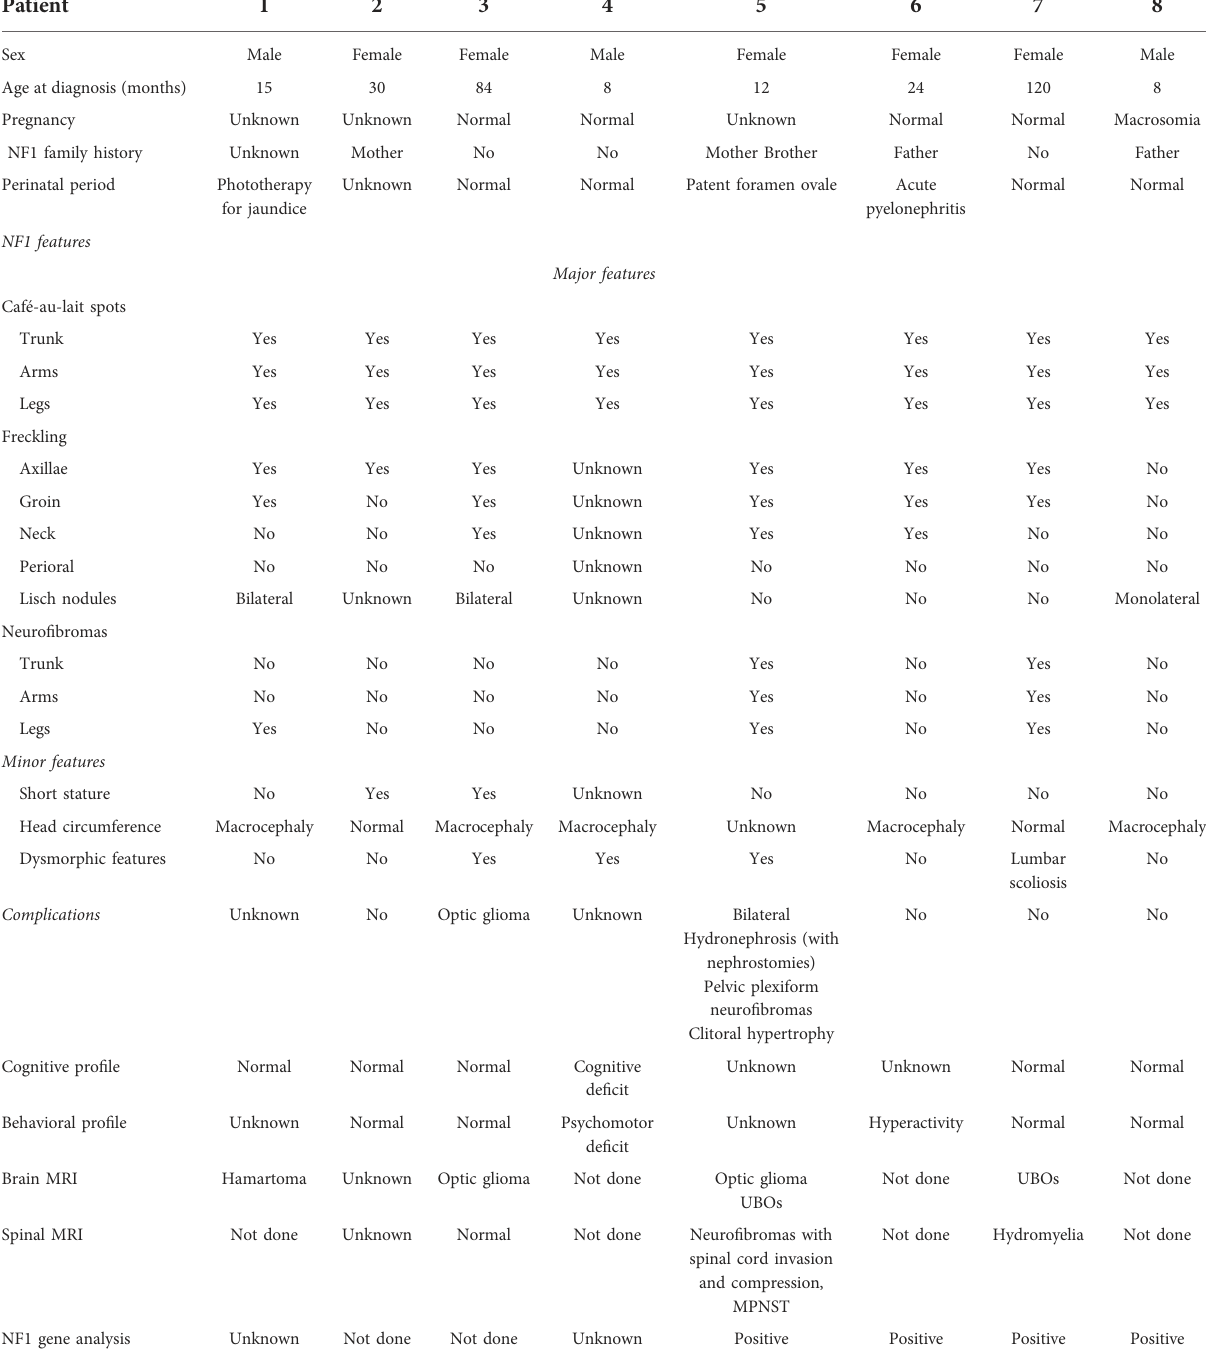
TABLE 2 Characteristics of NF1 in eight